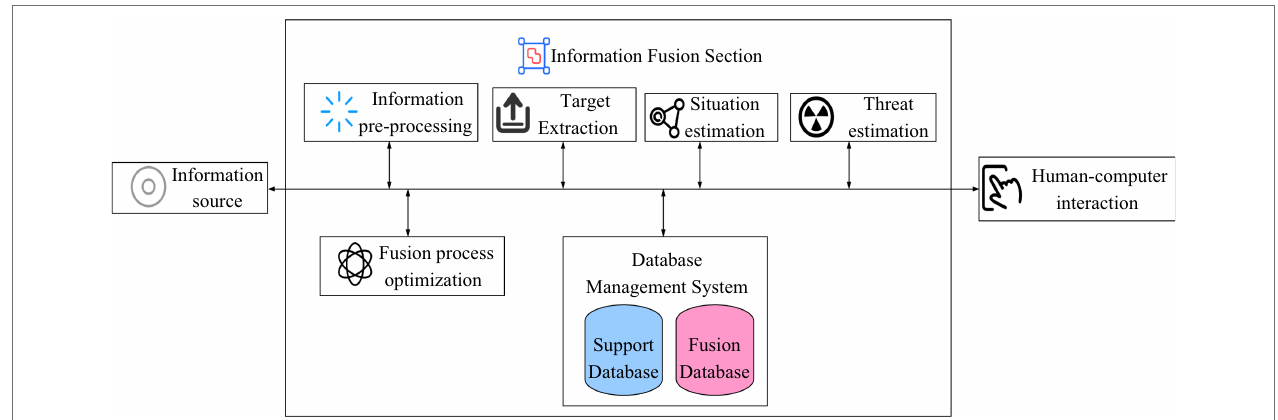
FIGURE 1 | JDL data fusion